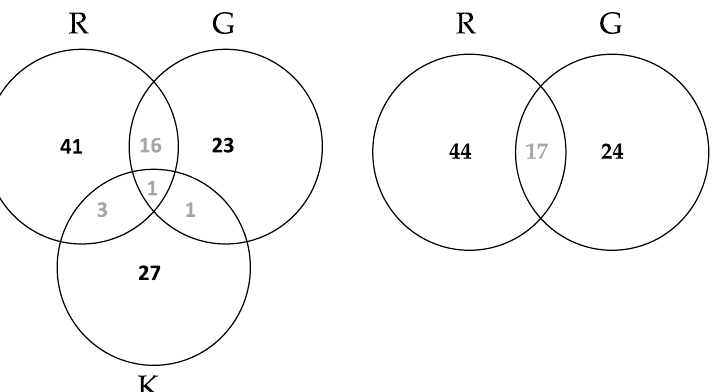
Figure 1. Number of unique and common OTUs isolated from leaf and root samples from Roosky, Glasnevin, and Kinsealy. Leaf endophyte Roosky = R, Glasnevin = G, and root endophytes Kinsealy = K. Root endophytes were only isolated from Kinsealy.